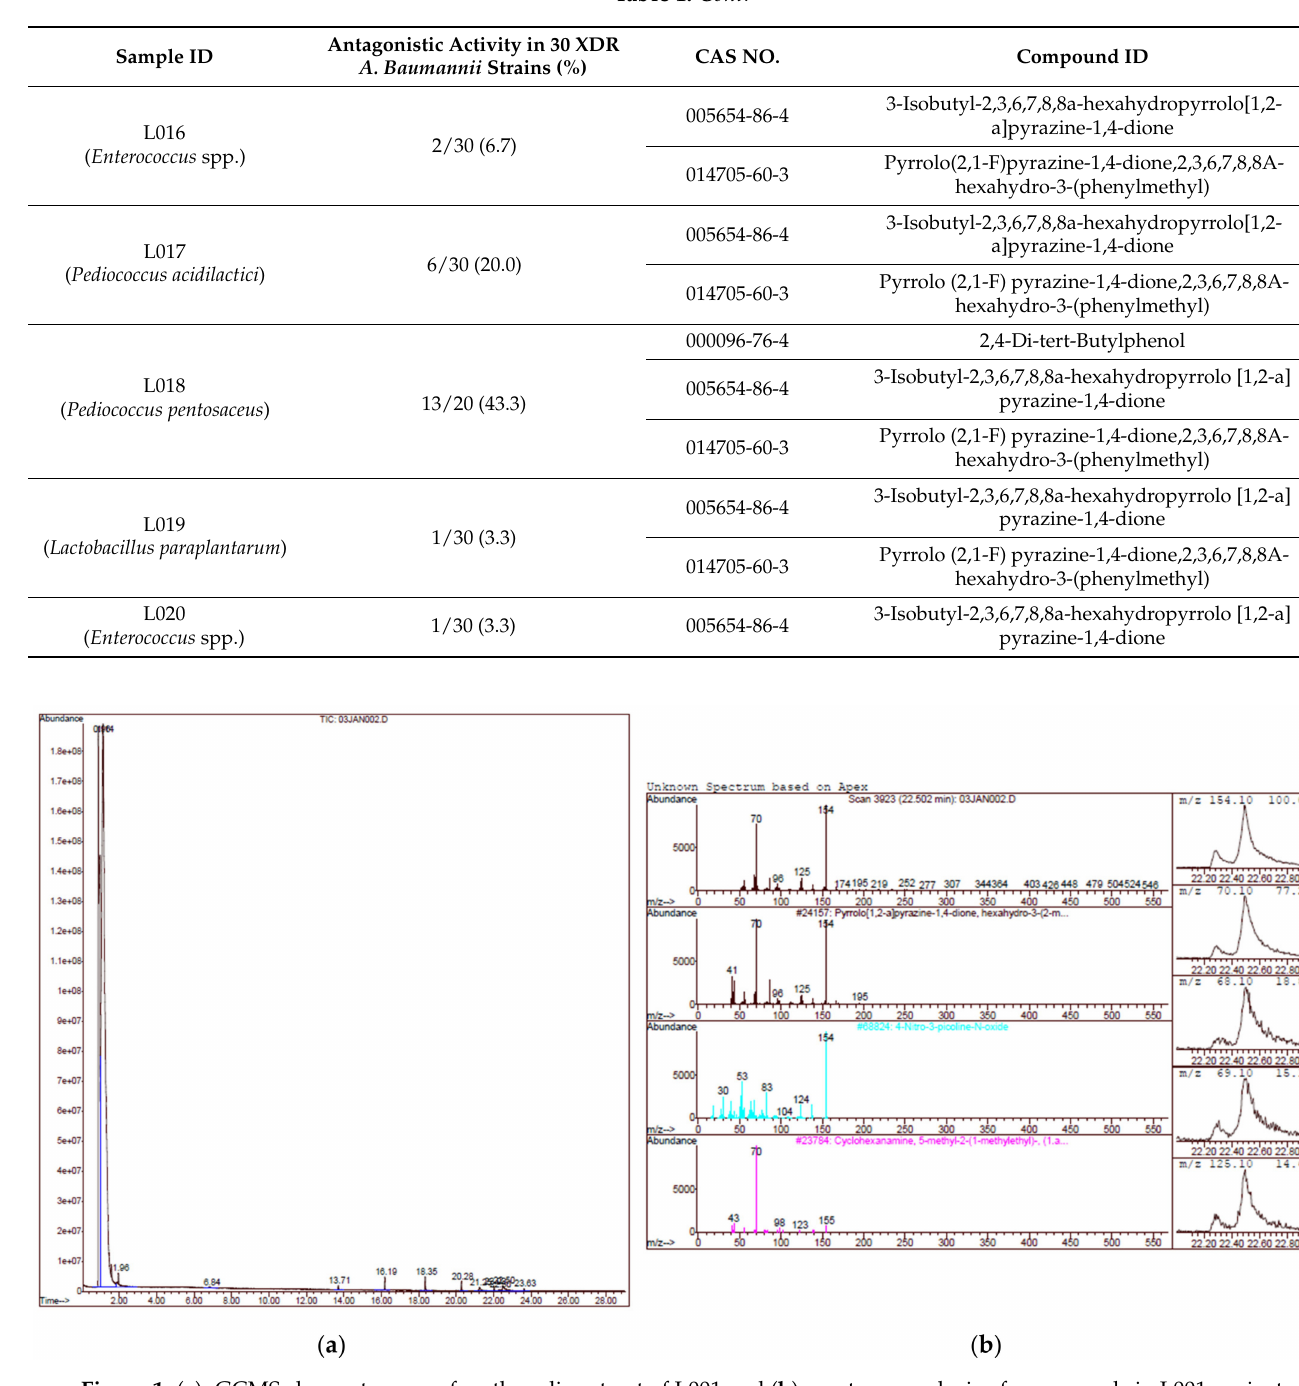
Figure 1. ( a ). GCMS chromatogram of methanolic extract of L001 and ( b ) spectrum analysis of compounds in L001 against